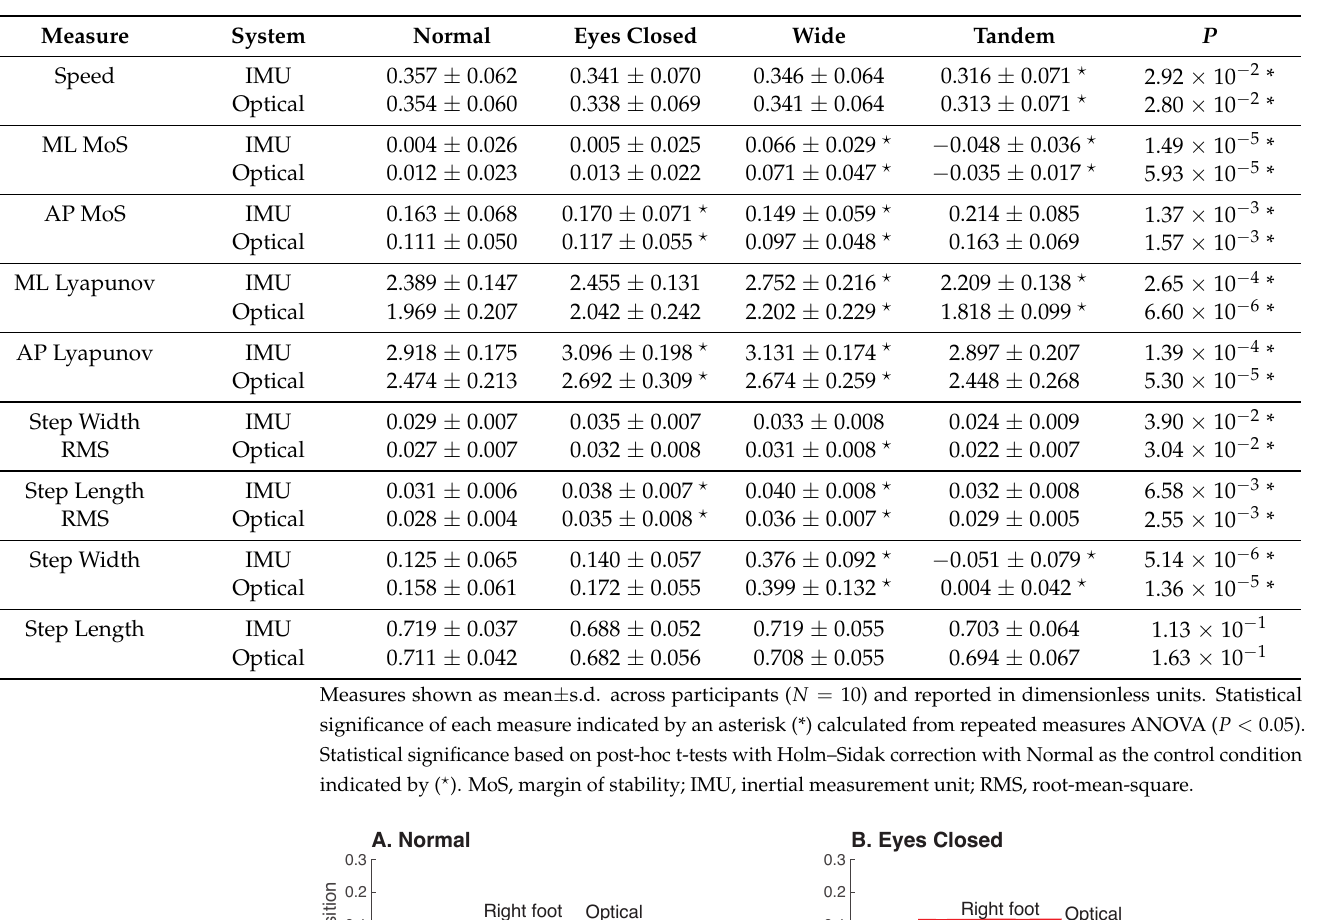
Table 1. Summary of quantitative measures and statistical results.